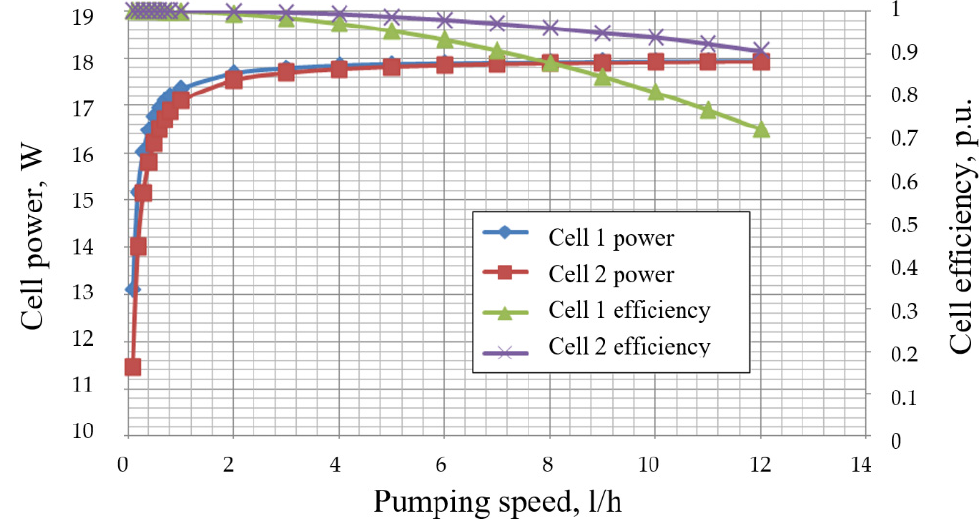
Figure 4. Dependences of the cells power and their efficiency on the rate of electrolyte flow through the cell.